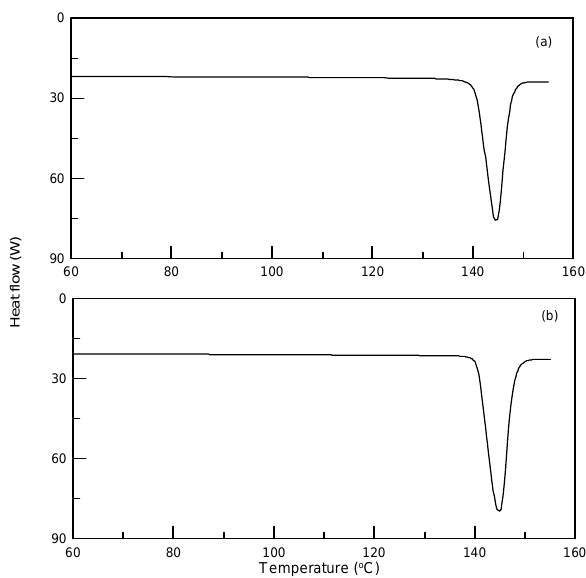
Figure 6. DSC results of salicylamide: ( a ) original crystals and ( b ) salicylamide crystals obtained in Experiment 1.